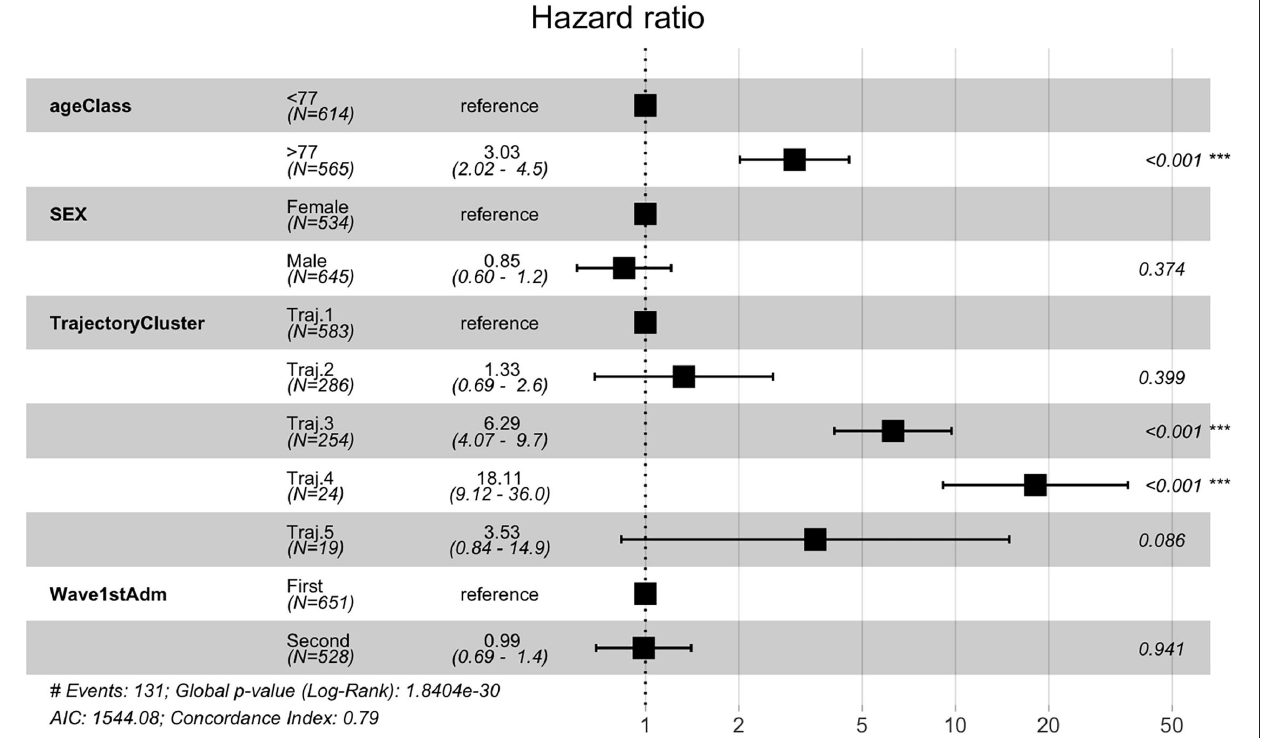
FIGURE 9 | Cox Regression results reported as Hazard Ratio + 95 % confidence interval for hazard ratio and significance codes for